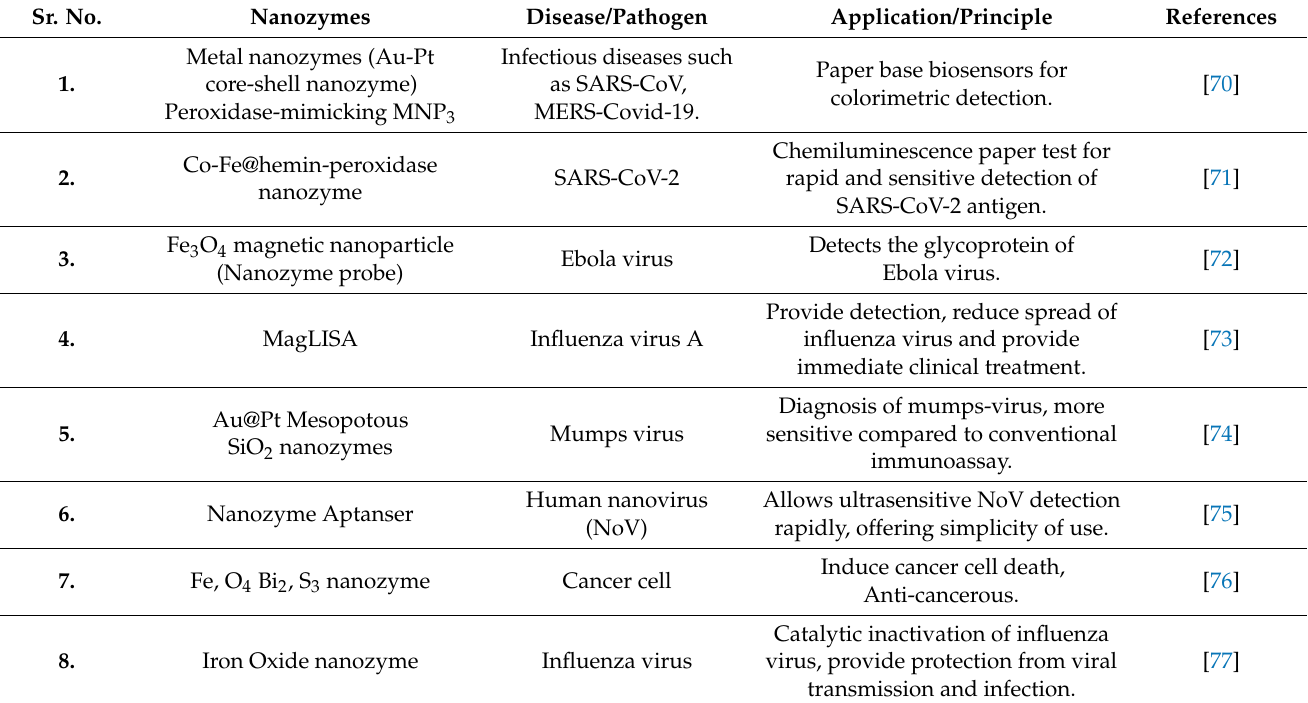
Table 2. Nanozymes used in different antiviral